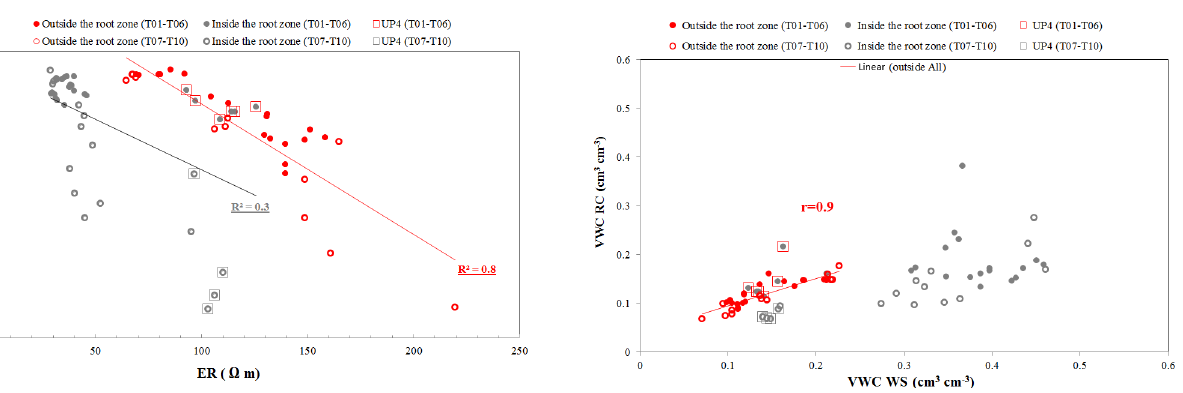
Figure 9. VWC predicted by the Waxman and Smits model com- pared to that predicted by the retention curve outside the root zone (red circles) and inside the root zone (gray circles). Filled circles represent the wet period (T01 to T06) and open circles the dry pe- riod